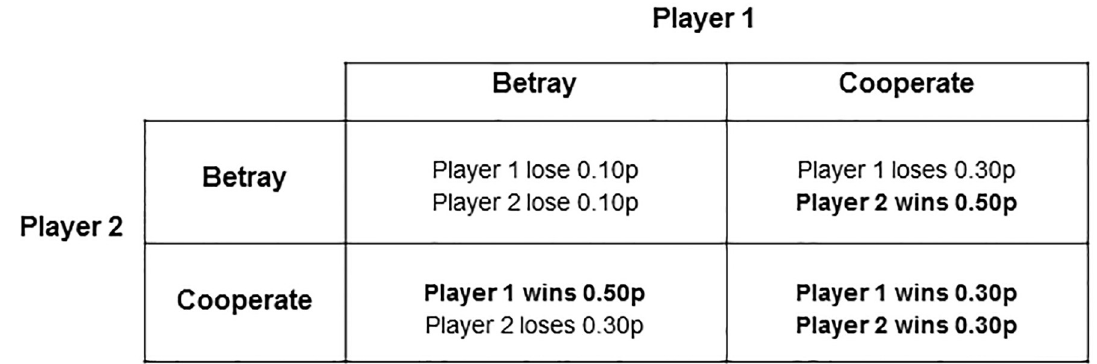
Fig 1. Payoff table. Each player had two options, cooperate or betray, and there are 4 outcomes based on both players’ decisions. The payoff scheme is designed to encourage betrayal, as betraying assuming the other cooperates is associated with the highest gains, as in the original